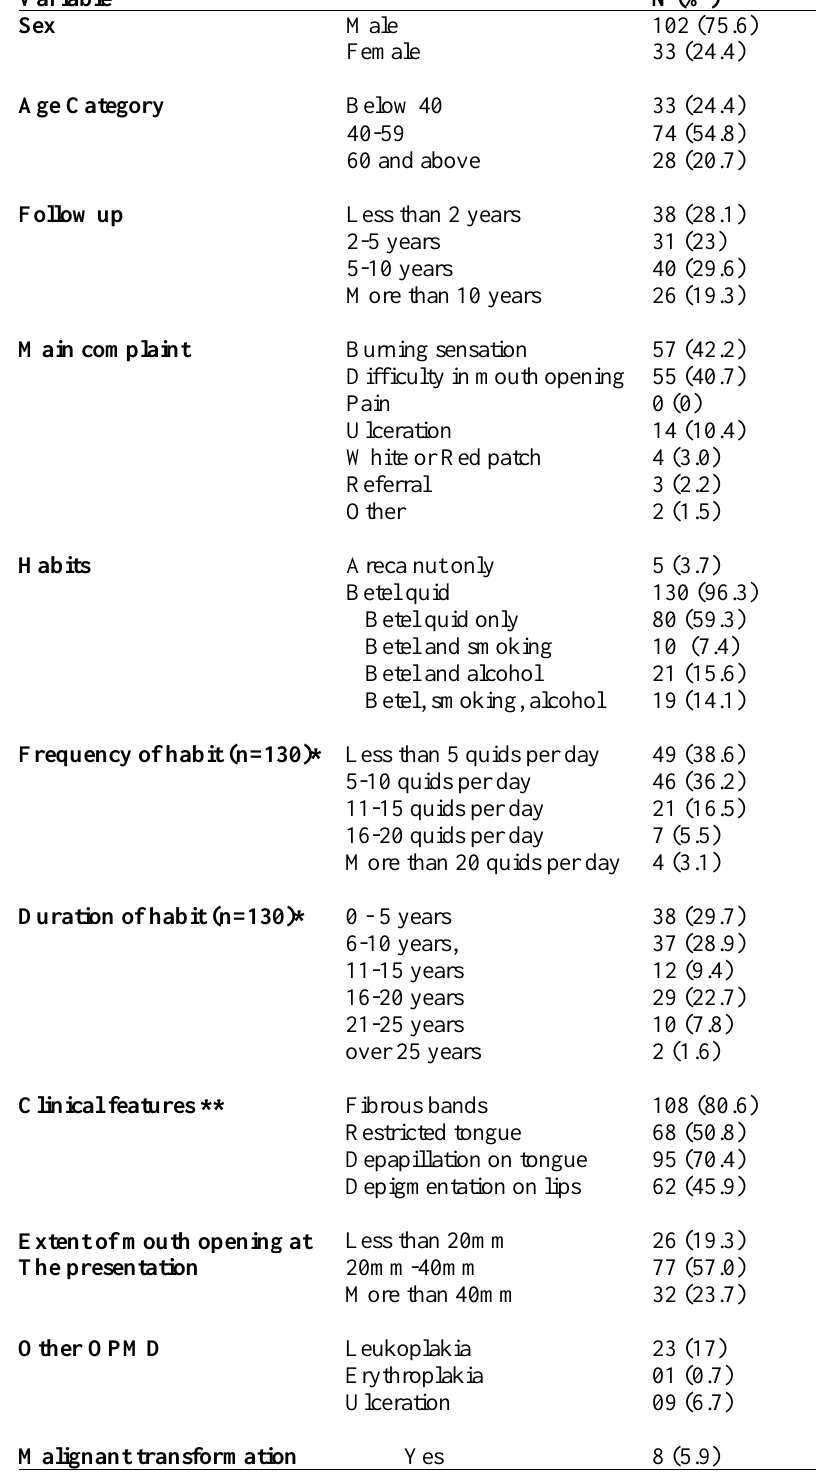
Table 1. Demographic and other characteristics of the patients, n=135